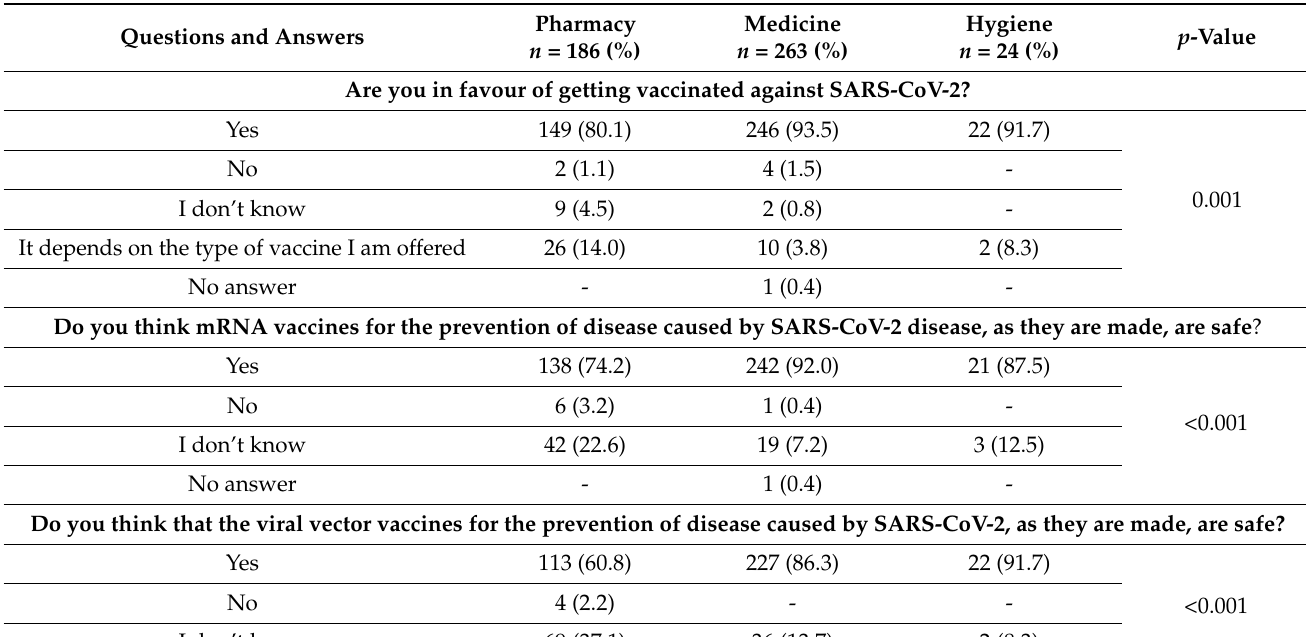
Table 4. Attitudes and perceptions towards vaccines against